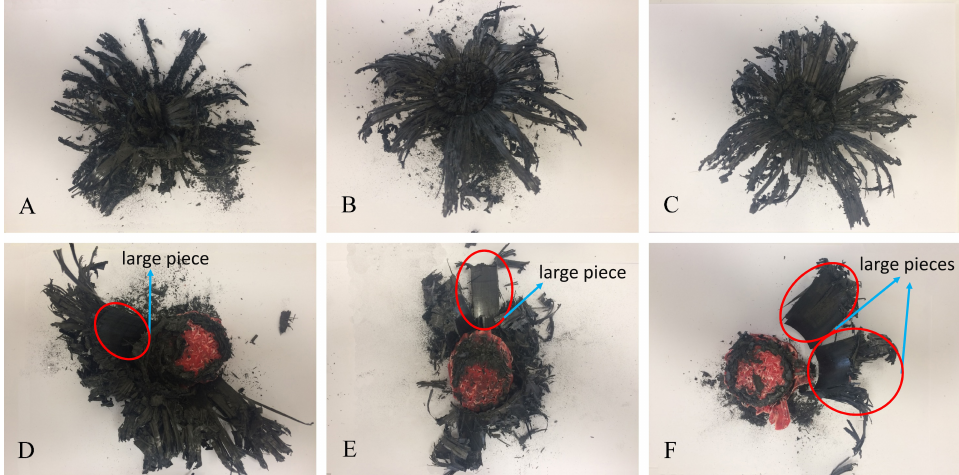
Figure 12. Deformed under uniaxial load. ( A – C ) Hollow and chiral; ( D – F ) lattice-filled composite tubes.